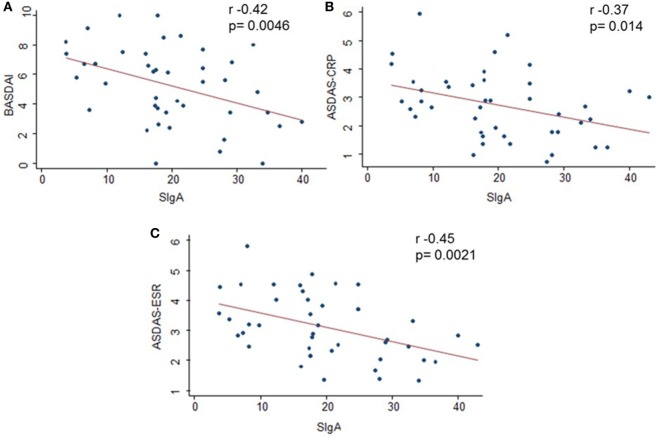
Correlation between serum secretory immunoglobulin A (SIgA) and clinical index. A moderate negative correlation was found between SIgA and the disease activity measurements. Correlations were evaluated by Pearson tests. A p value of <0.05 was considered statistically significant. (A) Negative correlation between Bath Ankylosing Spondylitis Disease Activity Index and SIgA (p = 0.0046; r = −0.42). (B) Negative correlation between Ankylosing Spondylitis Disease Activity Score (ASDAS)-C-reactive protein (CRP) and SIgA (p = 0.014; r = −0.37). (C) Negative correlation between ASDAS-erythrocyte sedimentation rate (ESR) and SIgA (p = 0.0021; r = −0.45). x-axis: SIgA in serum (micrograms per milliliter).